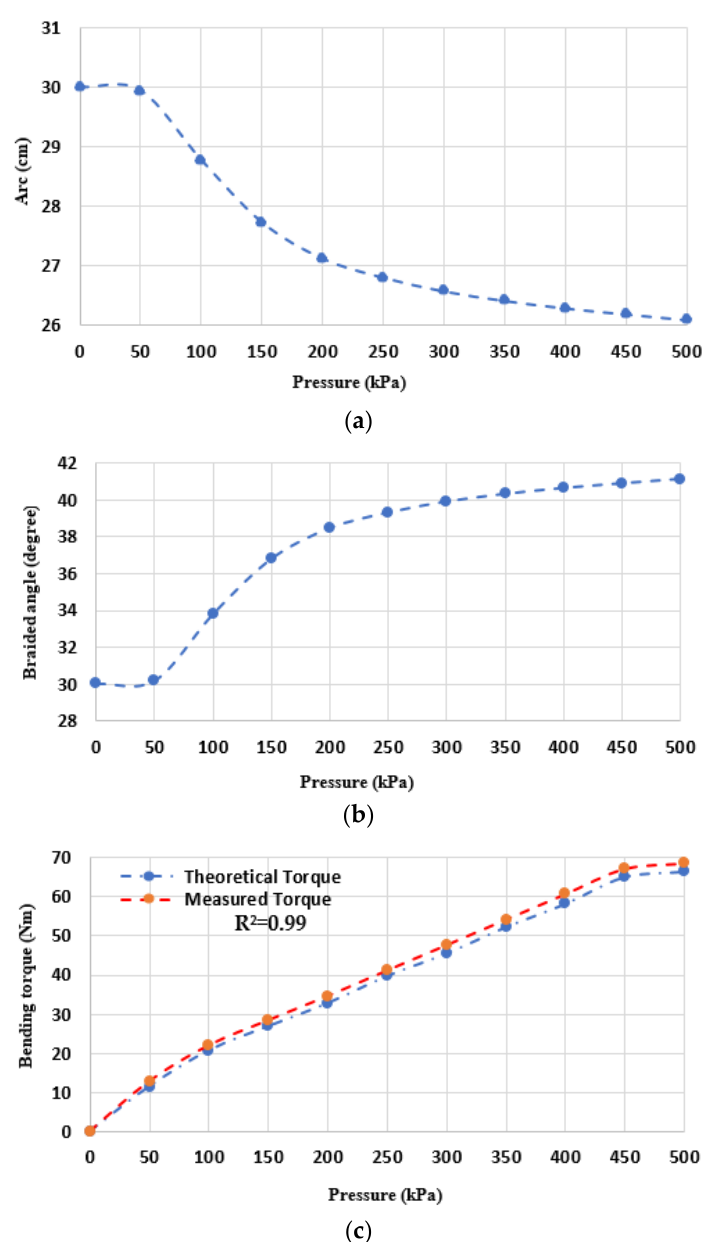
Figure 11. The performance of the 30 cm SBCA. ( a ) The behaviour of the Arc length. ( b ) The variation of the braided angle. ( c ) The bending torque as a function of air pressure.